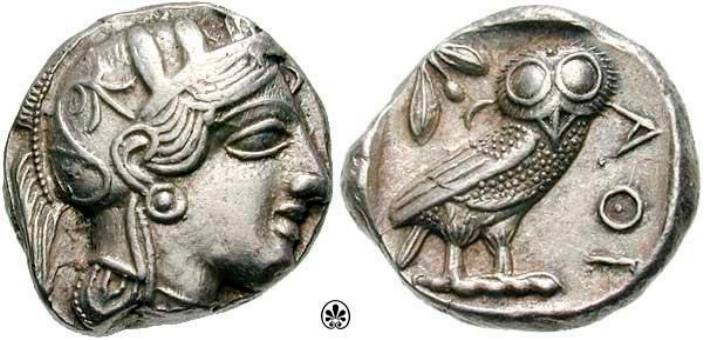
Figure 1. An Athenian tetradrachm. Source: http://www.wildwinds.com/coins/greece/attica/athens/ sg2526.jpg.